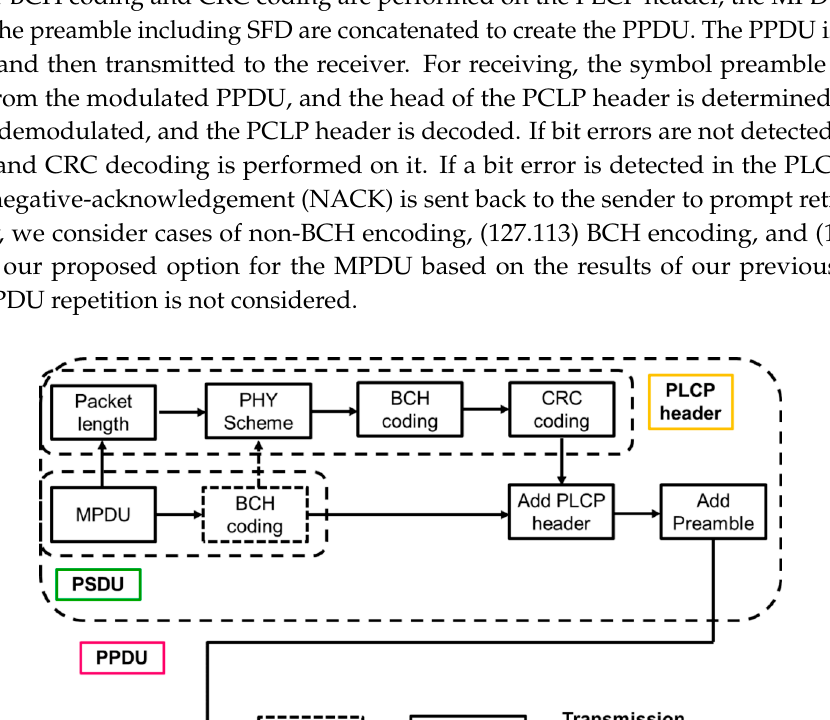
Figure 7. Block diagram of PHY receiver. Figure 6. Block diagram of PHY Figure 6. Block diagram of PHY transmitter.